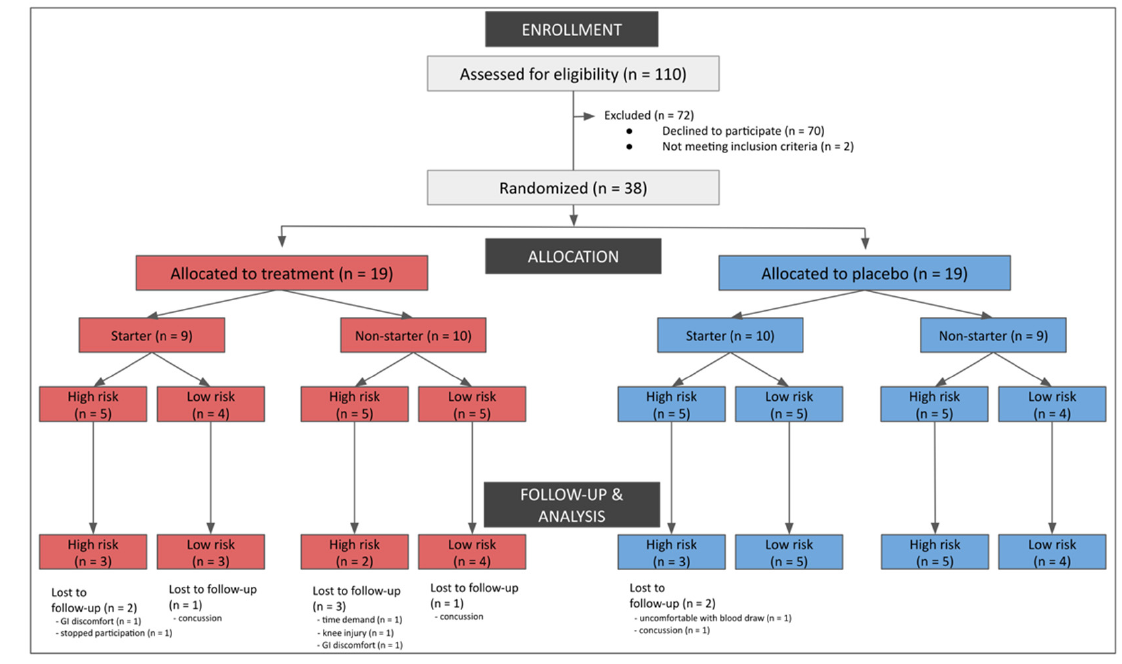
Figure 1. Consort diagram outlining reasons for exclusion.